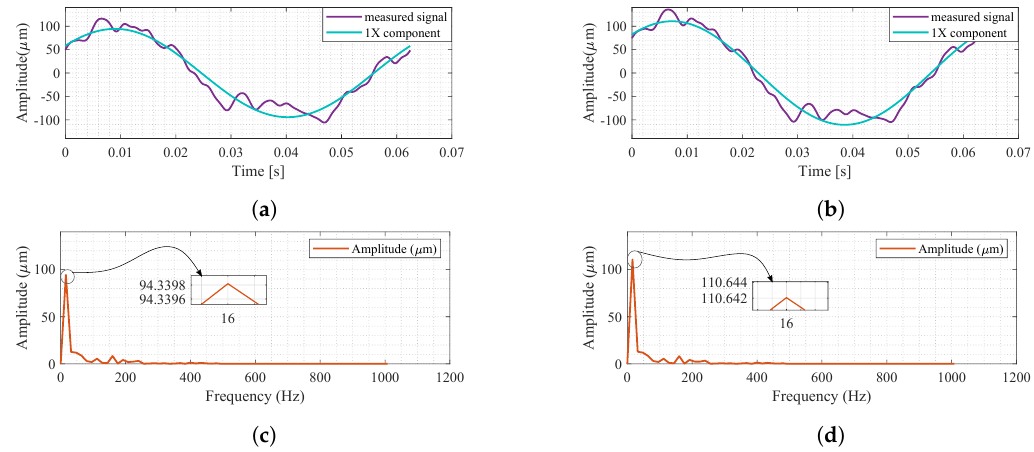
Figure 9. Extraction of 1X component from a measured signal using FFT. ( a , c ) are for the case without any additional mass and ( b , d ) show the process for the case with 0.056 kg · m